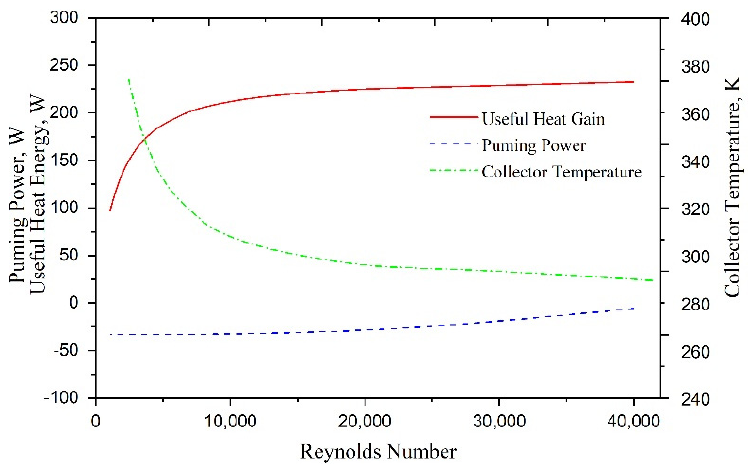
Figure 5. Variation of absorber temperature, heat gain and pumping power.